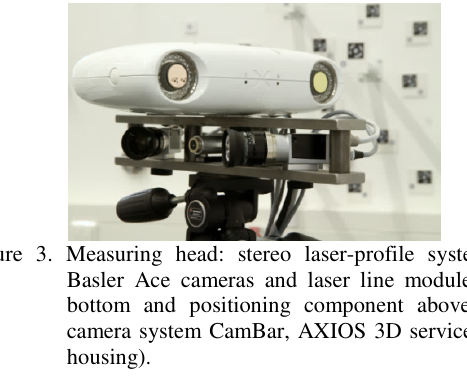
Figure 3. Measuring head: stereo laser-profile system (two Basler Ace cameras and laser line module) in the bottom and positioning component above (stereo camera system CamBar, AXIOS 3D services, white